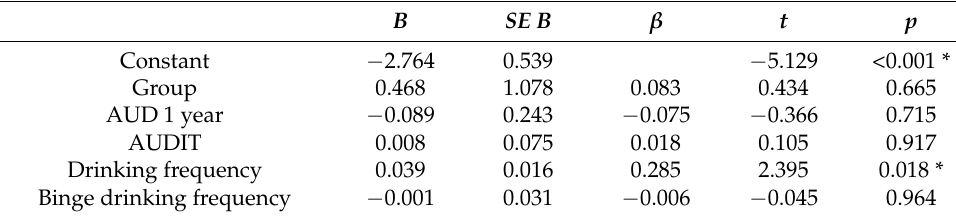
Table 5. Results of the multiple linear